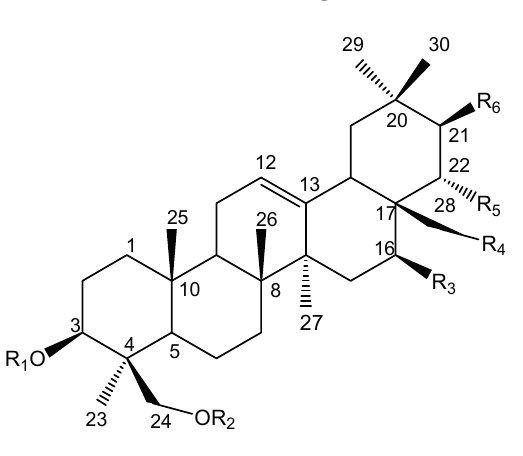
Figure 1. Chemical structures of triterpenes isolated from G. sylvestre